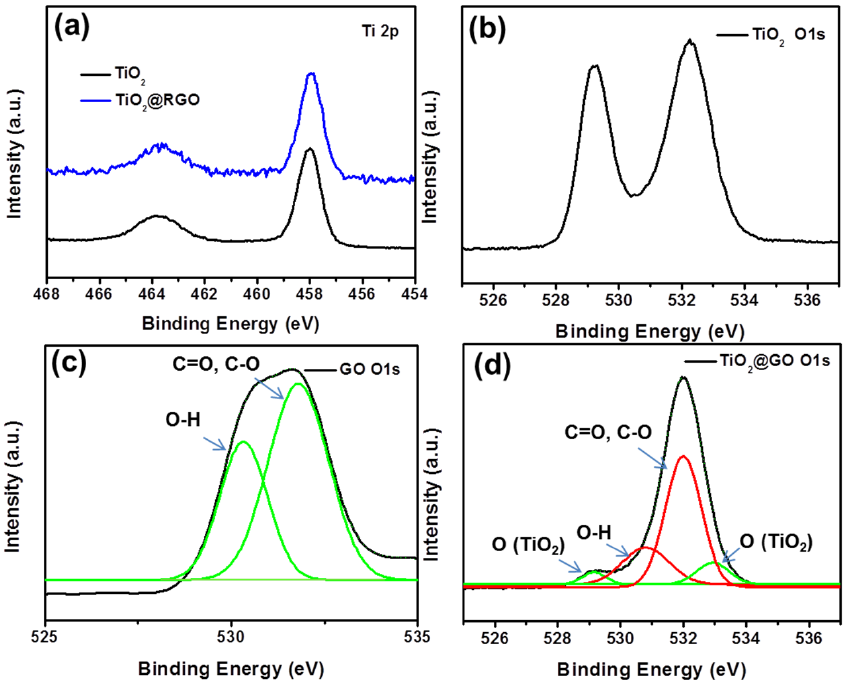
Figure 2. ( a ) XPS spectra of Ti 2p for TiO 2 and TiO 2 @GO, XPS spectra of O 1s for ( b ) TiO 2 , ( c ) GO